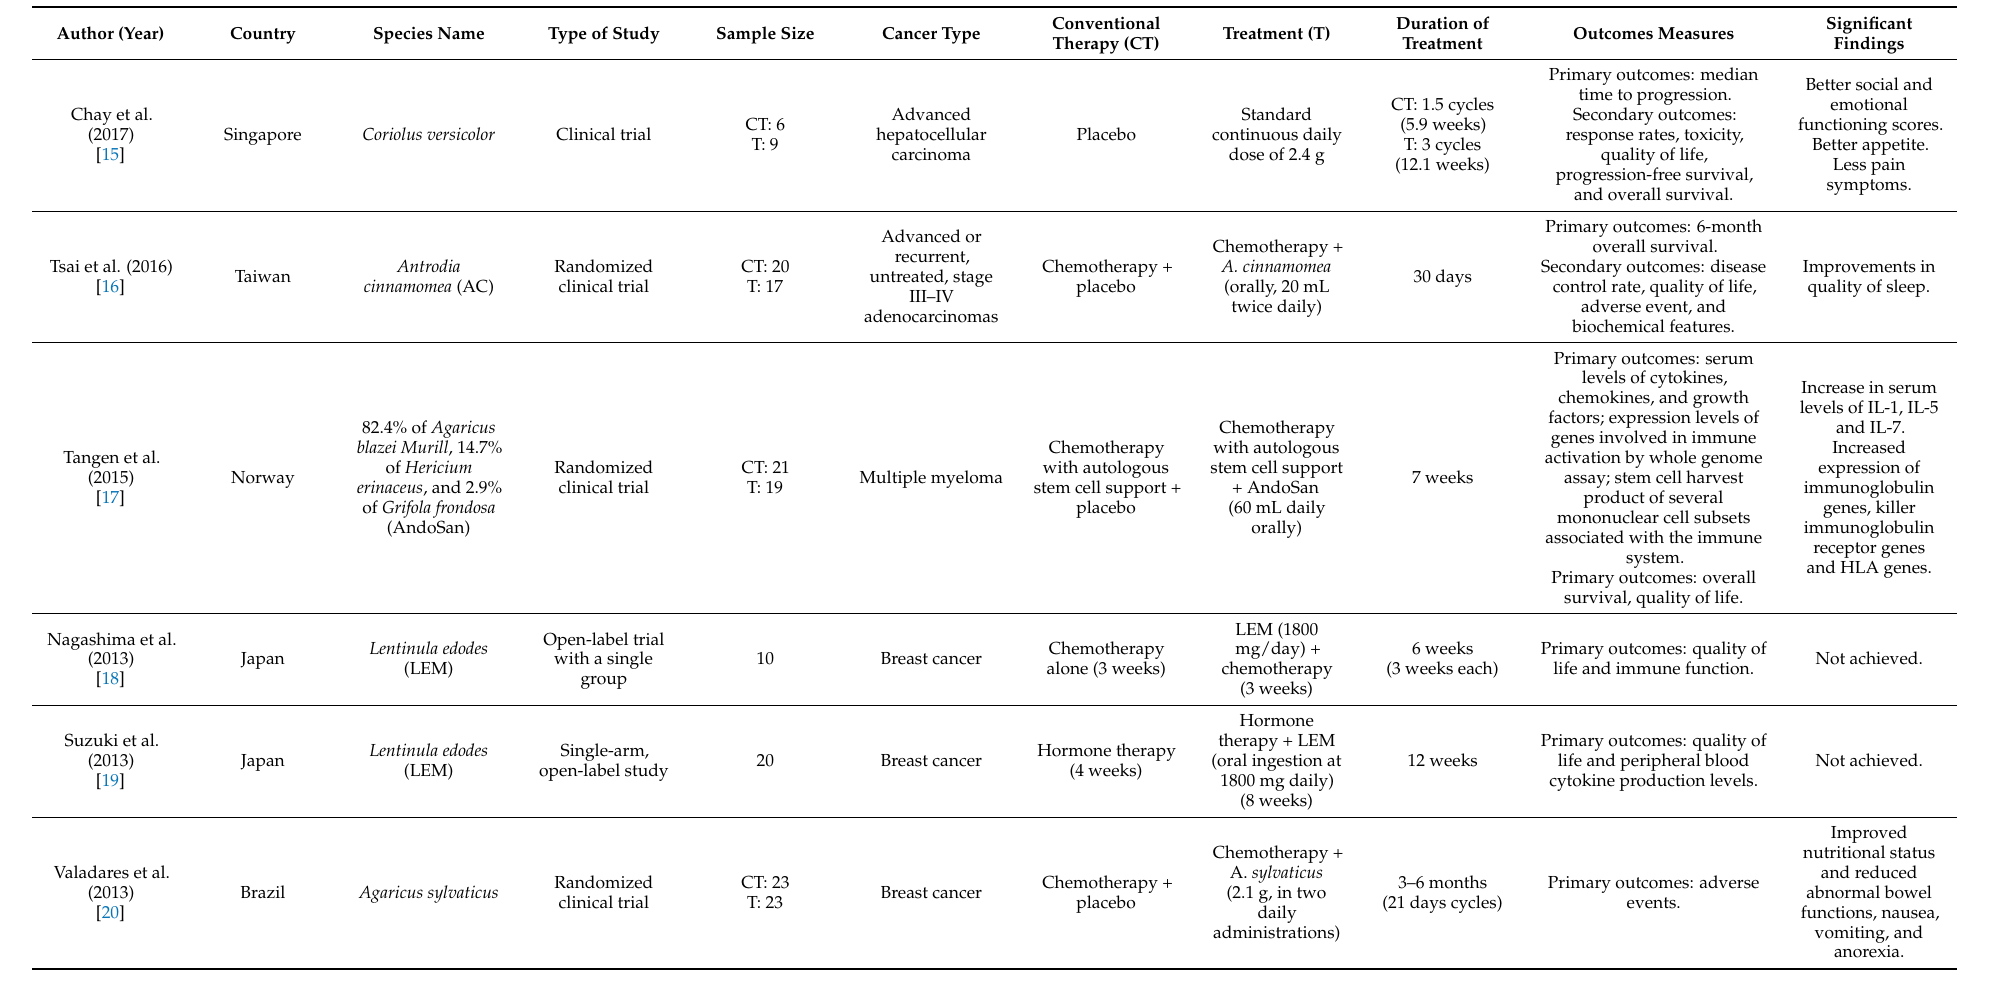
Table 1. Characteristics of the included